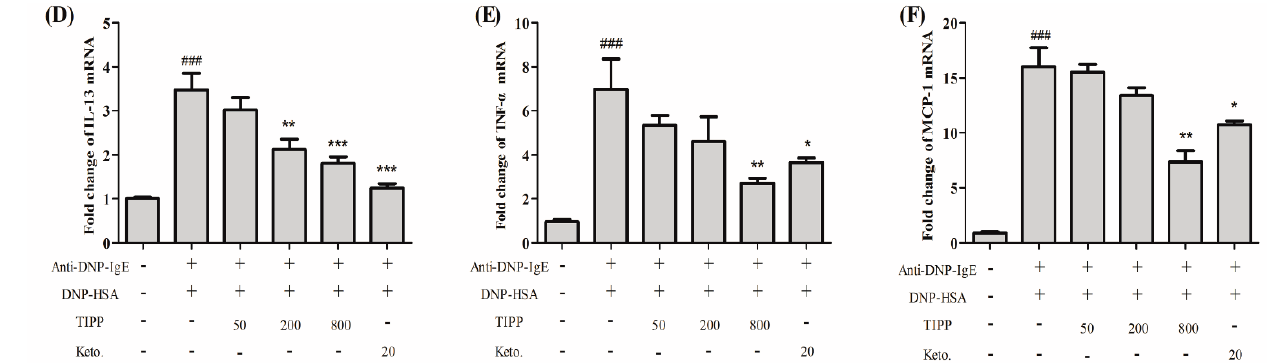
Figure 4. Effects of TIPP on the mRNA levels of ( A ) IL-3; ( B ) IL-4; ( C ) IL-6; ( D ) IL-13;